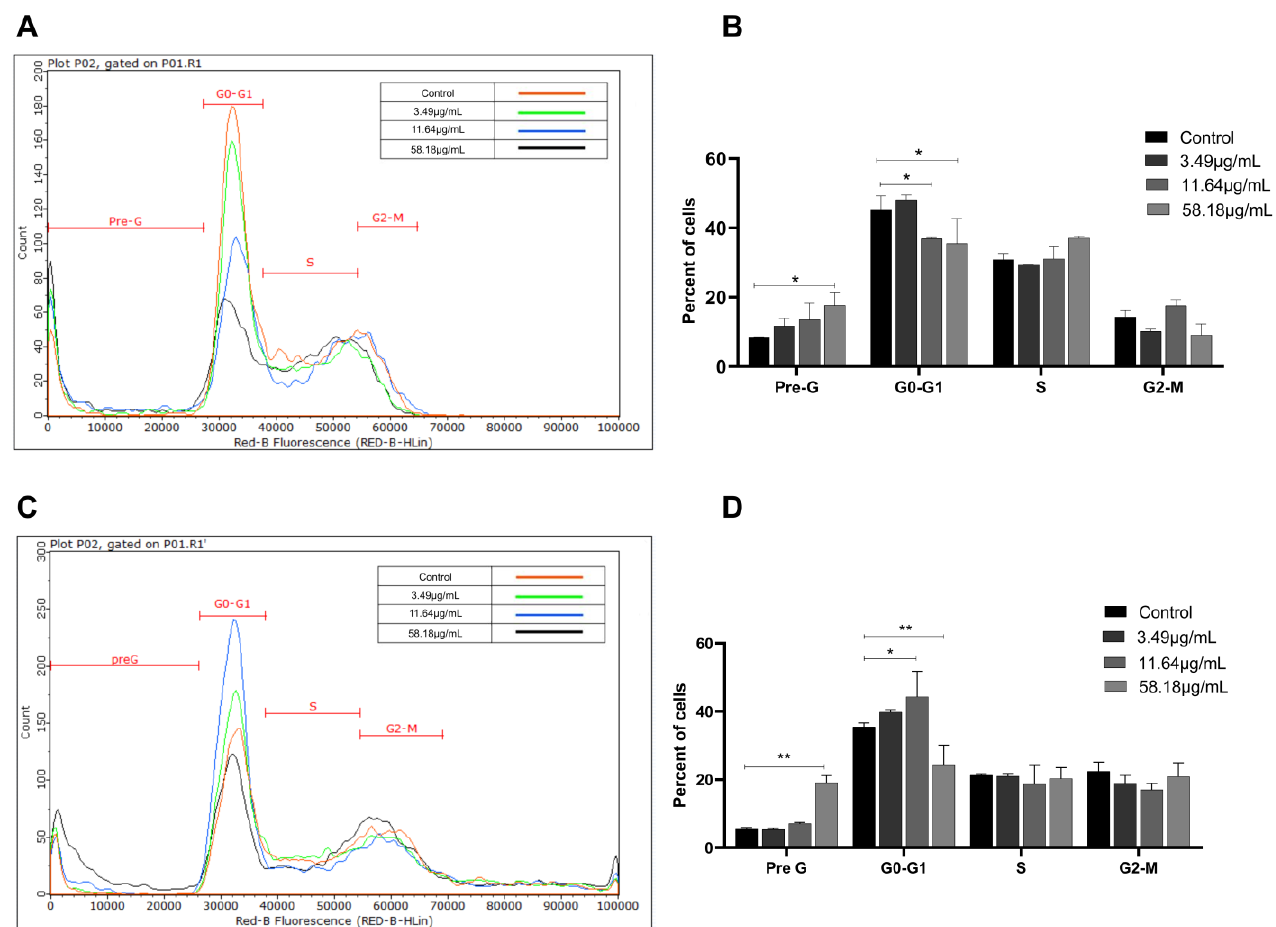
Figure 2. ScBEE induces cellular fragmentation in a dose-dependent manner in breast cancer cell lines. Cell cycle analysis of ( A ) MDA-MB-231 and ( C ) MCF-7 cells treated with increasing